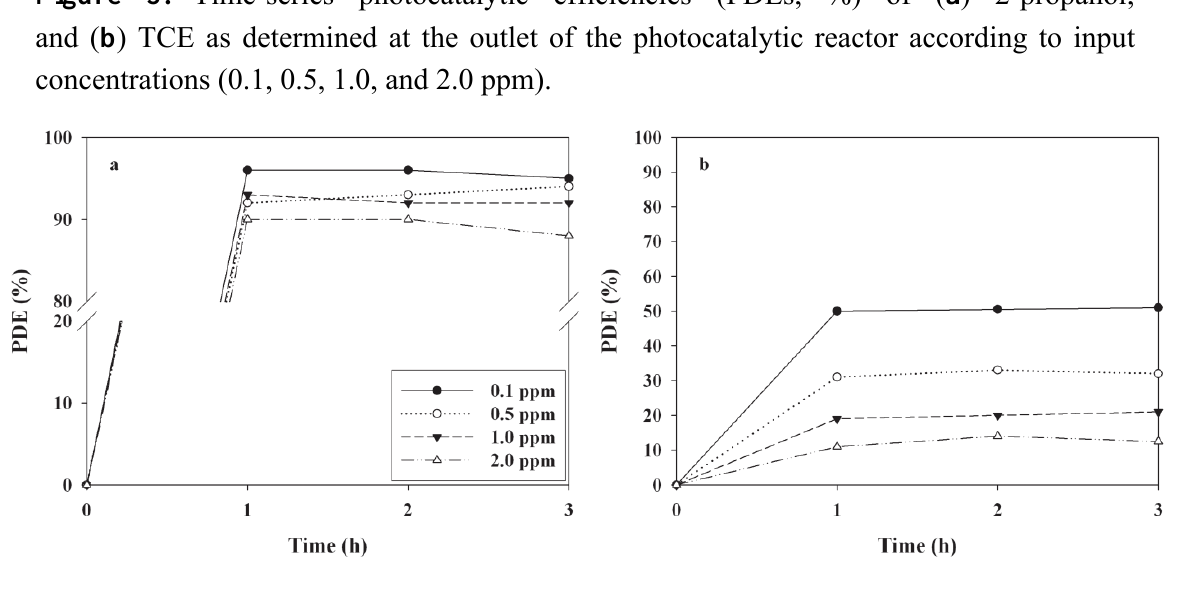
Table 2. Reaction rate (  -mole m − 2 s − 1 ) of 2-propanol and TCE according to